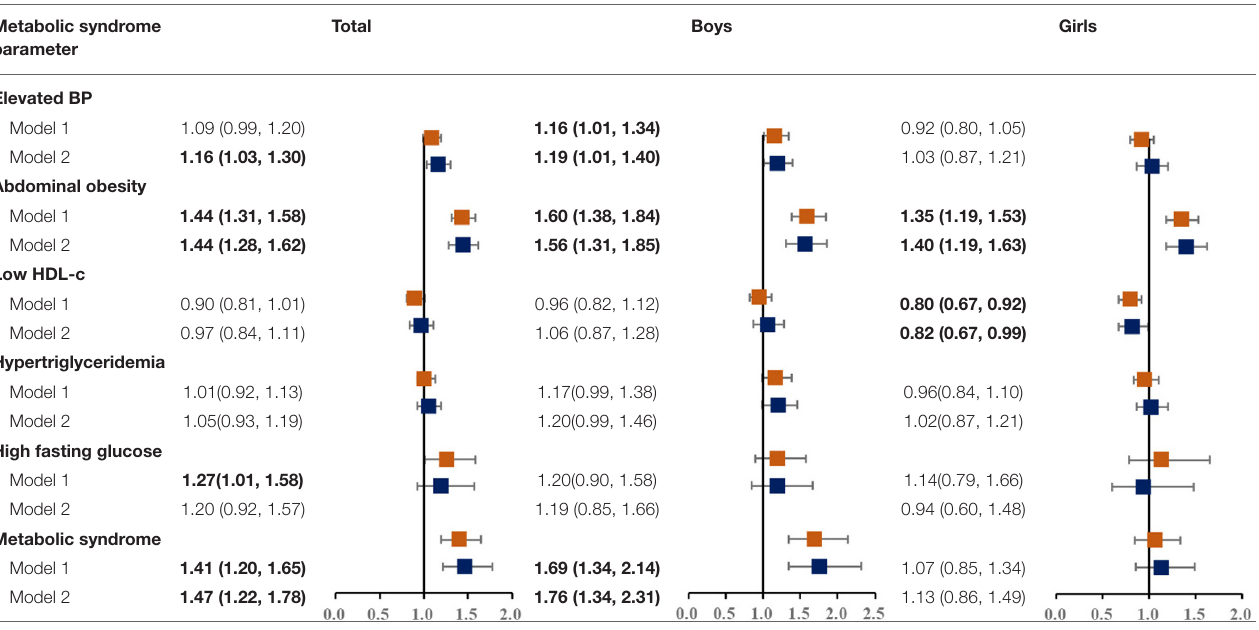
TABLE 3 | Multivariate odds ratios (OR) and 95% confidence intervals (CI) of MS according to single child status, stratified by sex.